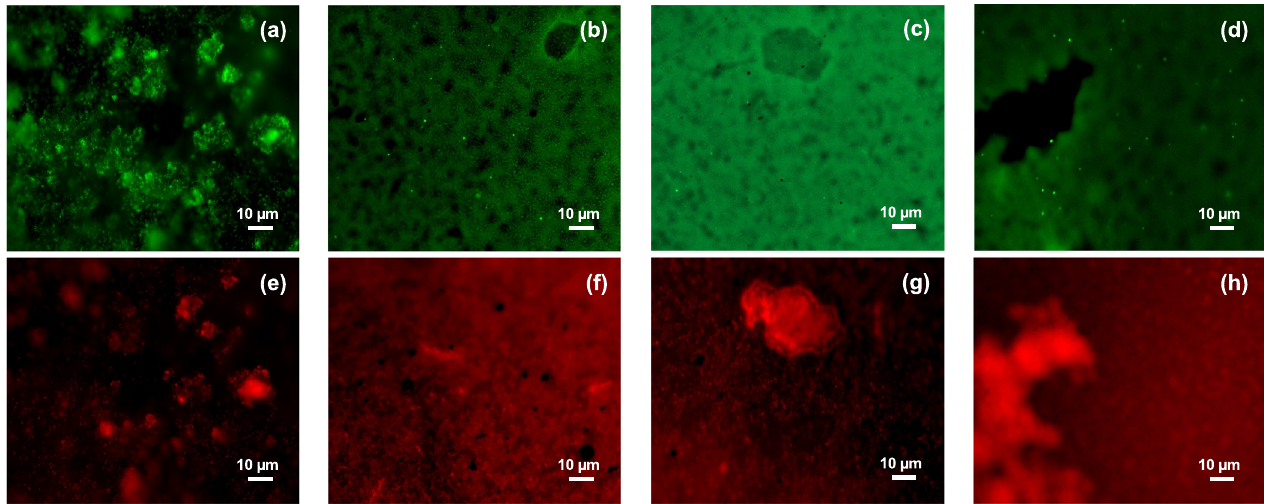
Fig. 6 LIVE/DEAD Bio fi lm imaging of polyurea coatings. a , e Pure_polyurea, with b , f un_TiO 2 , c , g 3%Ce-doped TiO 2 , and d , h 3%La-doped TiO 2 in Pseudomonas